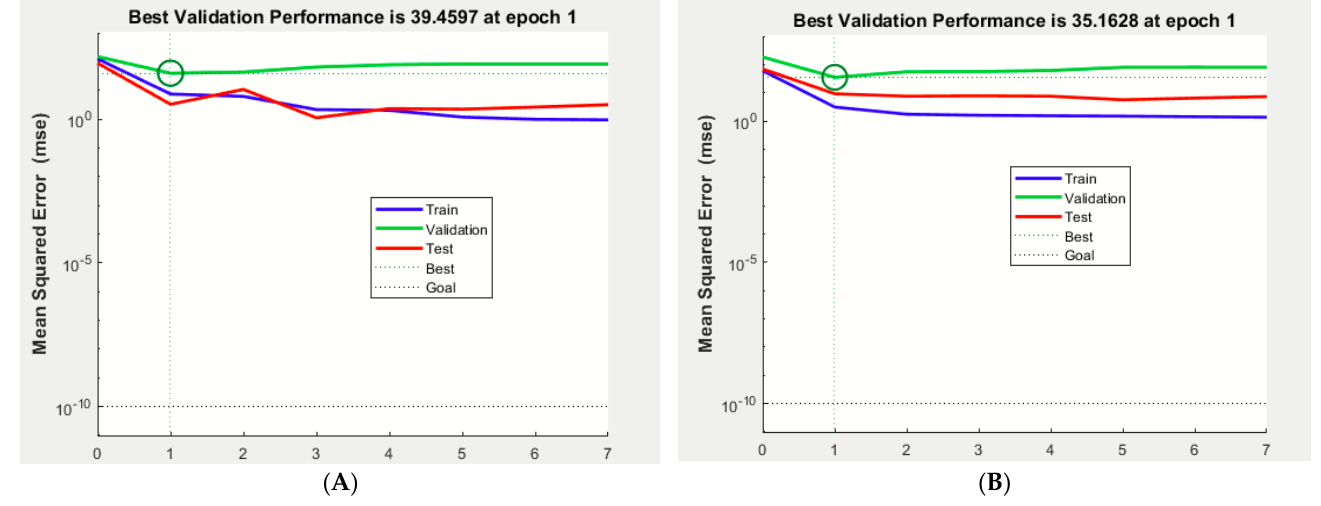
Figure 1. Best validation performance for ANFIS analysis with low MSE and minimal training RMSE was 0.365148. ( A ) E. carotovora Erw 5 . ( B ) E. carotovora EMCC 1687.